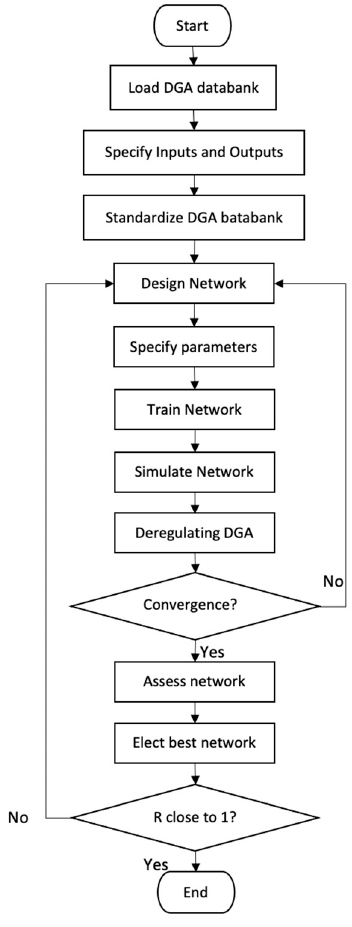
Figure 3. Proposed MLANN flowchart.